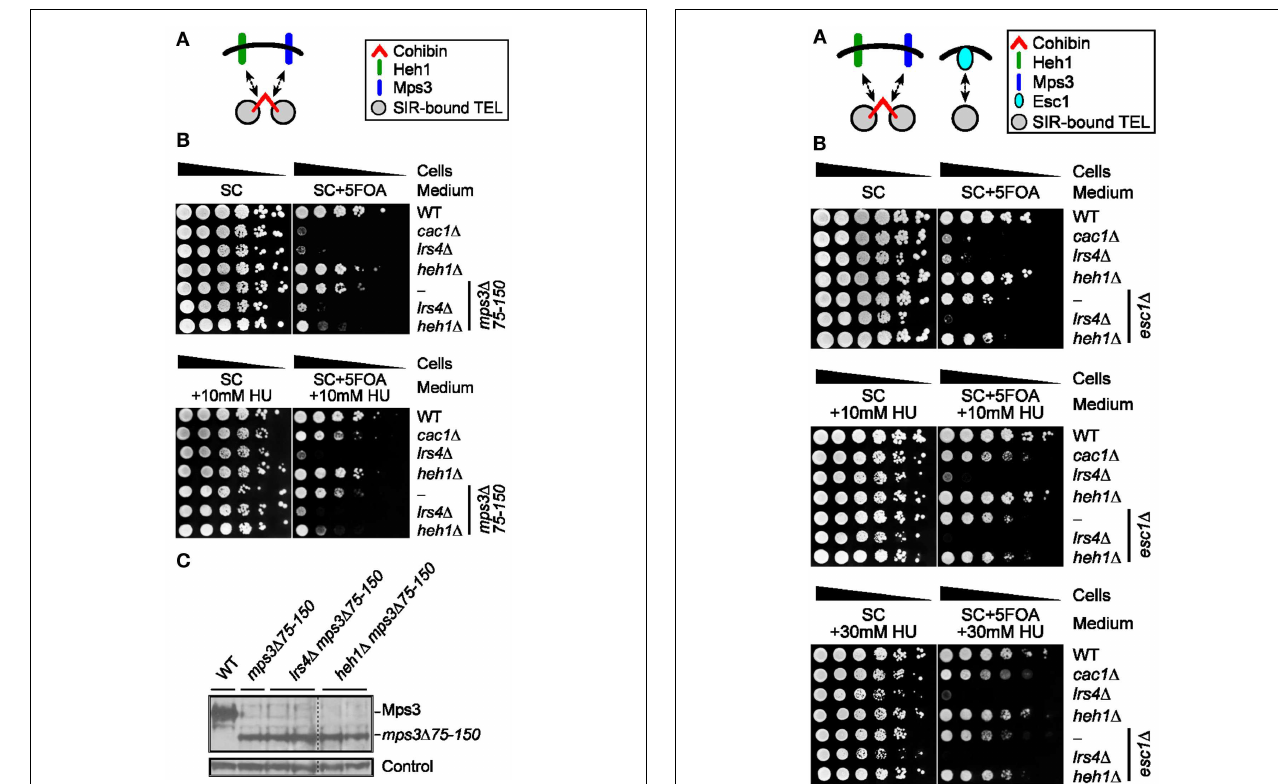
FIGURE 5 | Pharmacological inhibition of RNR function does not restore FOA-resistance in cells lacking Esc1 and/or cohibin-dependent telomere tethering. (A) Schematic showing relationship between cohibin-dependent and Esc1-dependent perinuclear telomere tethering. (B) Serial dilutions of cells with the URA3 reporter inserted proximal to telomereVII-L were plated on synthetic complete (SC) medium or medium supplemented with sublethal concentrations of hydroxyurea ( + HU) and/or 5FOA ( + 5FOA).WT, wild-type. Strains: KMY368, KMY1465, KMY74, KMY59, KMY404, KMY492,